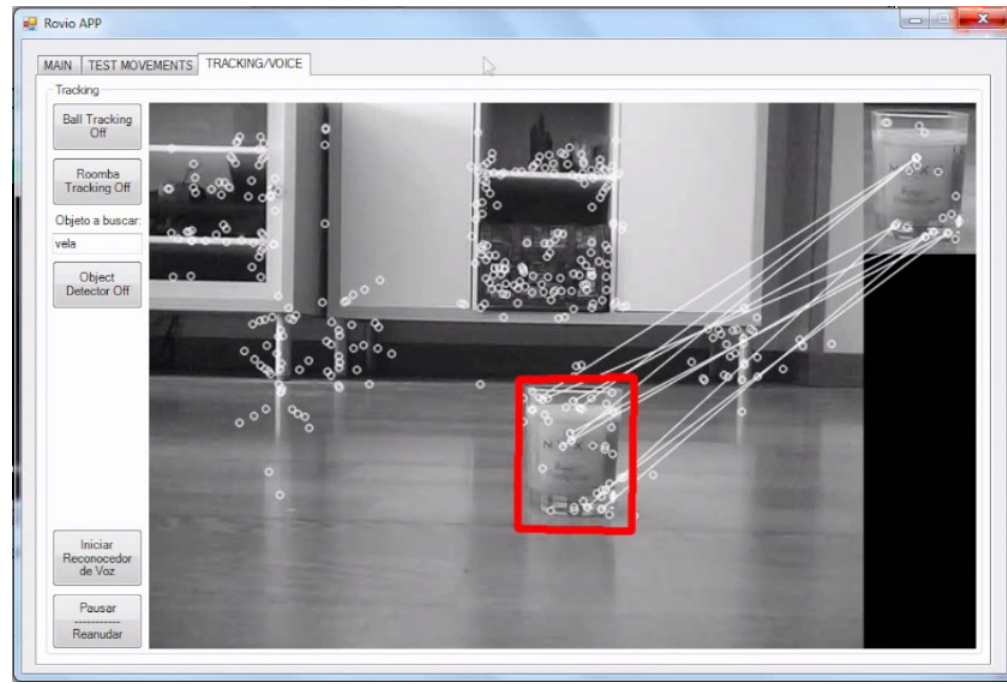
Figure 6. Rovio finds the candle